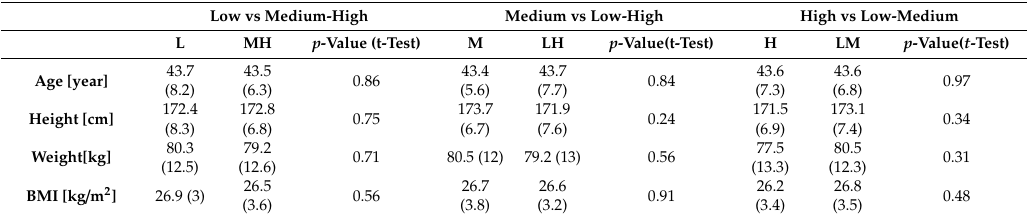
Table 5. Statistical analysis on demographic data for all combinations of 2-class